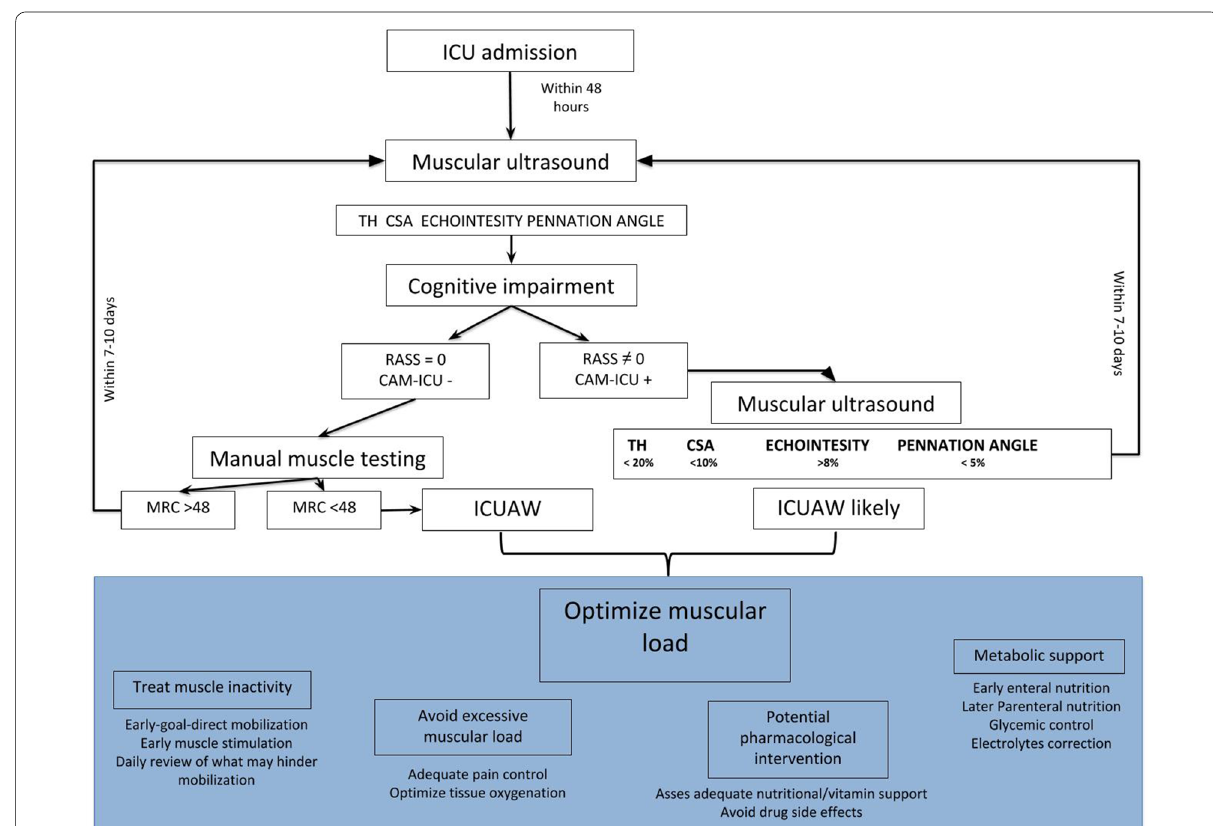
Fig. 6 The muscle ultrasound flowchart for the assessment and minimization of ICUAW. This flowchart suggests a protocol for logical and early identification of ICUAW. Ideally, within the first 48 h, a first muscle ultrasound assessment should be performed for a baseline picture of patient muscle characteristics (the evaluation should at least regard the quadriceps rectus femoris, and it may be “omni-comprehensive” of muscle thickness (TH), cross-sectional area (CSA), echointensity (if the operator is familiar with any image editing software), pennation angle. At the same time, the cognitive impairment should be evaluated using standard reproducible scales (such as the Richmond agitation sedation scale and the confusion assessment method for the ICU). If these scores are in the normal range, the application of manual muscle testing such as the medical research council scale is possible. These first evaluations might be reconsidered within the first 7–10 days after the admission in the ICU, and their modifications over time, integrated with each other as well as with the reevaluation of MRC scale, allow an accurate diagnosis of ICUAW and should be used to modify the different patient-dependent factors, such as pharmacological strategies, muscular overloading or inactivity, and metabolic derangements. RASS Richmond agitation sedation scale, CAM-ICU confusion assessment method for the ICU, ICU intensive care unit, MRC Medical Research Council scale, TH muscle thickness, CSA cross-sectional area, ICUAW ICU-acquired